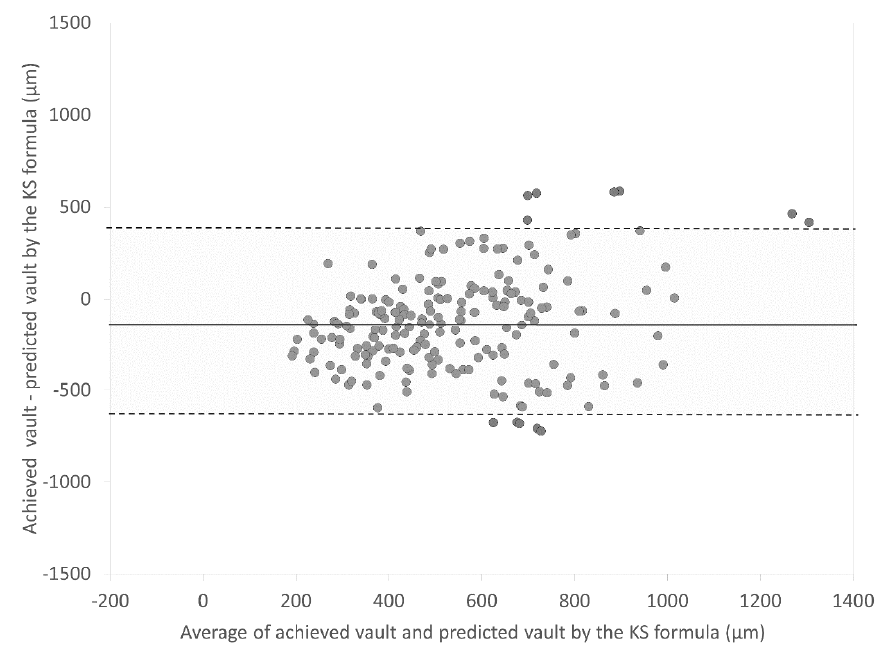
Figure 2. Bland–Altman plots showing the difference between the achieved vault and the predicted vault by the KS formula divided by the mean of the achieved vault and the predicted vault. The solid line represents the mean difference between two consecutive measurements of corneal astigmatism, dotted lines are the upper and lower borders of the 95% LoA (mean difference ± 1.96 multiplied by standard deviation of the mean difference).